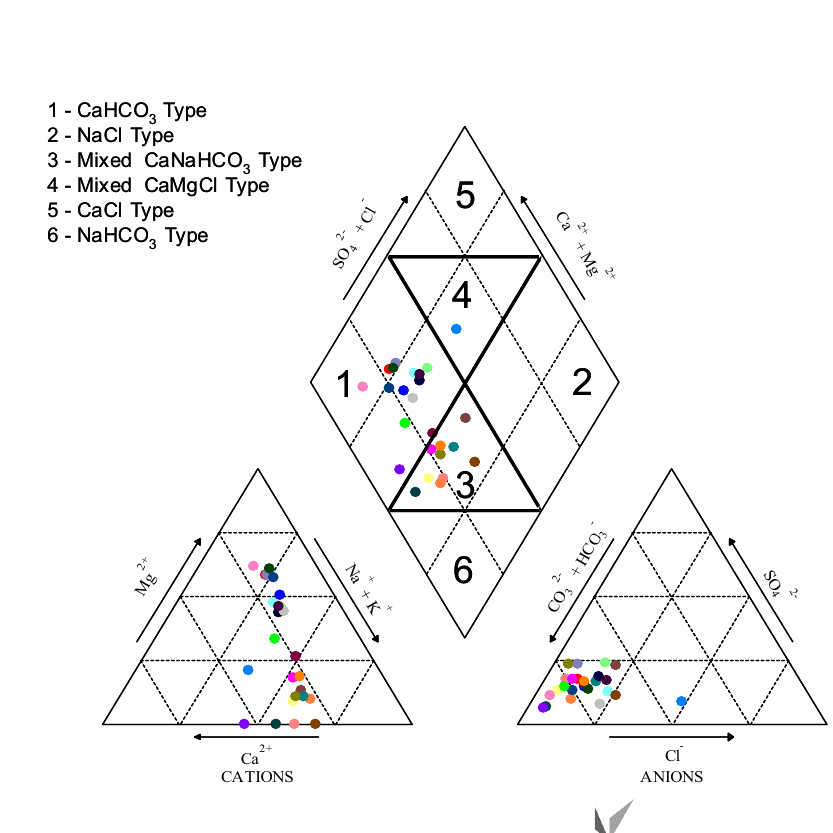
Fig. 2 Piper-trilinear diagram for geochemical classification of